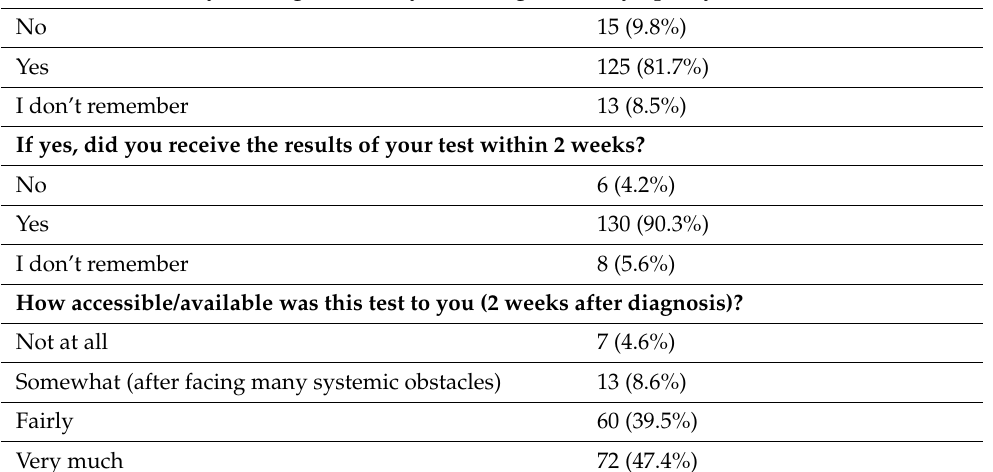
Table 2. Baseline Screening for CD4 lymphocytes and viral load (HIV RNA), within 2 weeks of